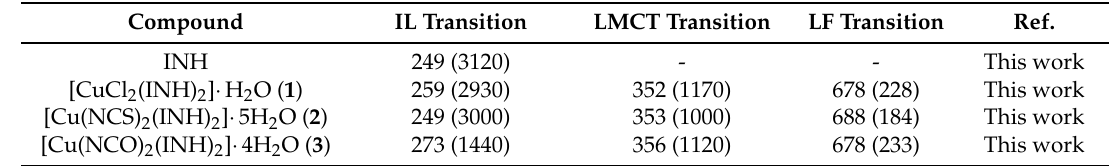
Table 2. UV-Vis spectral data a of INH and the Cu(II) complexes (1.0 × 10 − 3 mol·L − 1 ). Compound IL Transition LMCT Transition LF Transition Ref.